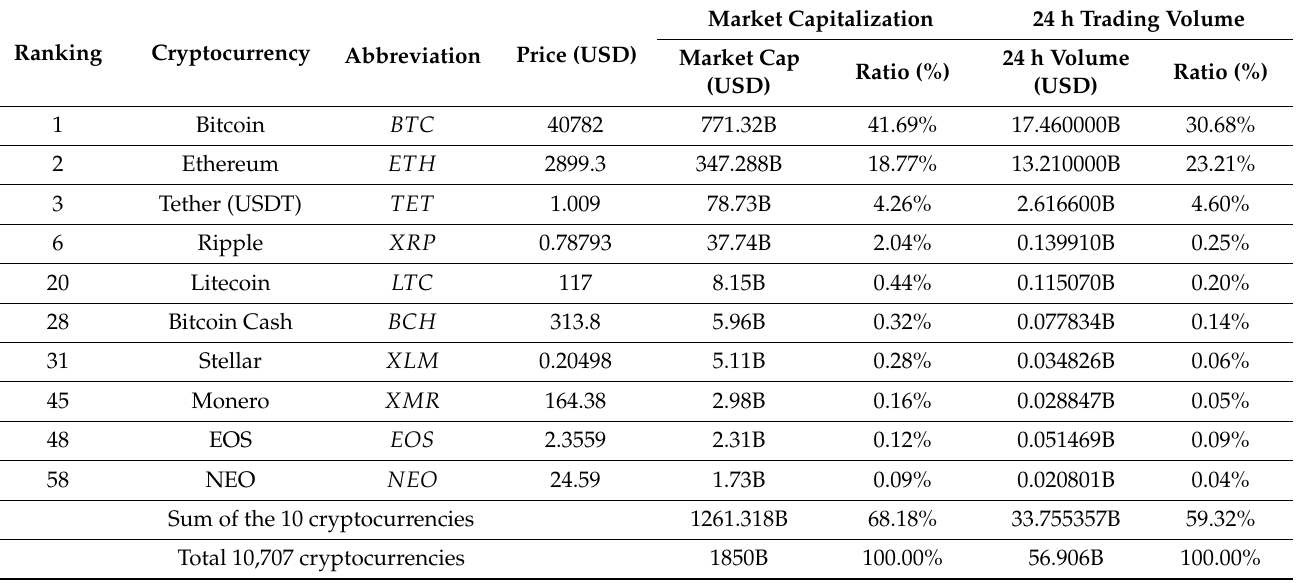
Table 1. Ranking, price, market cap, and 24 h trading volume of the 10 cryptocurrencies in the global market on 18 February